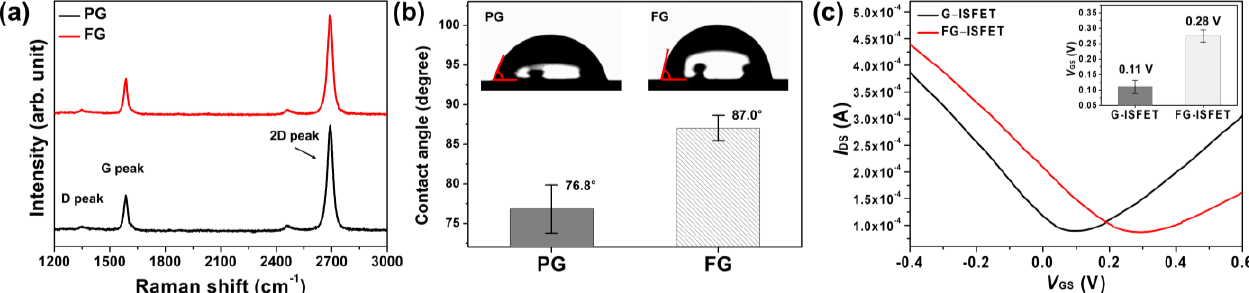
Figure 1. The characteristics of graphene before and after fluorobenzene treatment for 30 s: ( a ) Raman spectra; ( b ) water contact angles; and ( c ) I DS – V GS of G–ISFET and FG–ISFET.